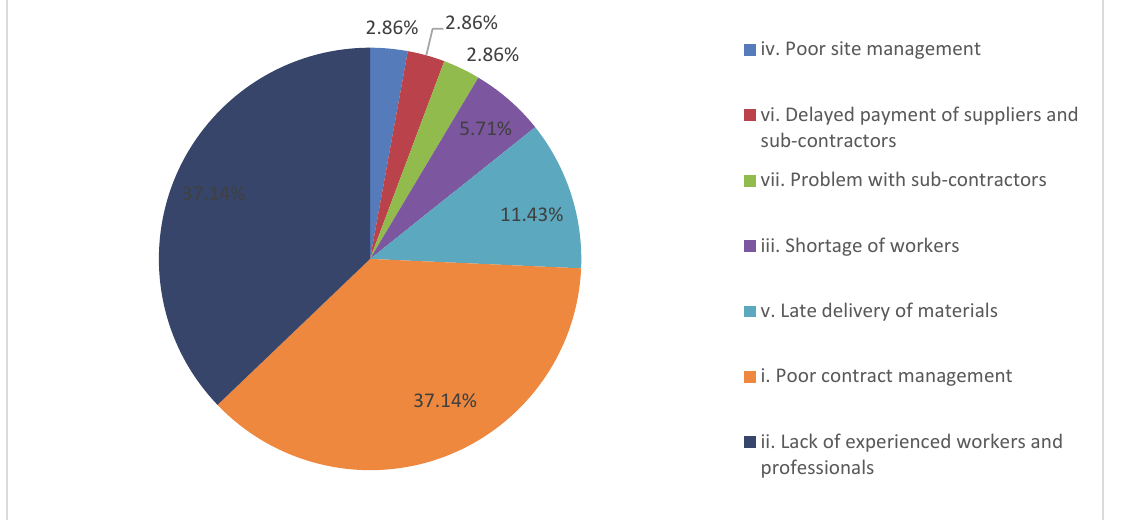
Fig. 3. Contractor-related causes of project delays